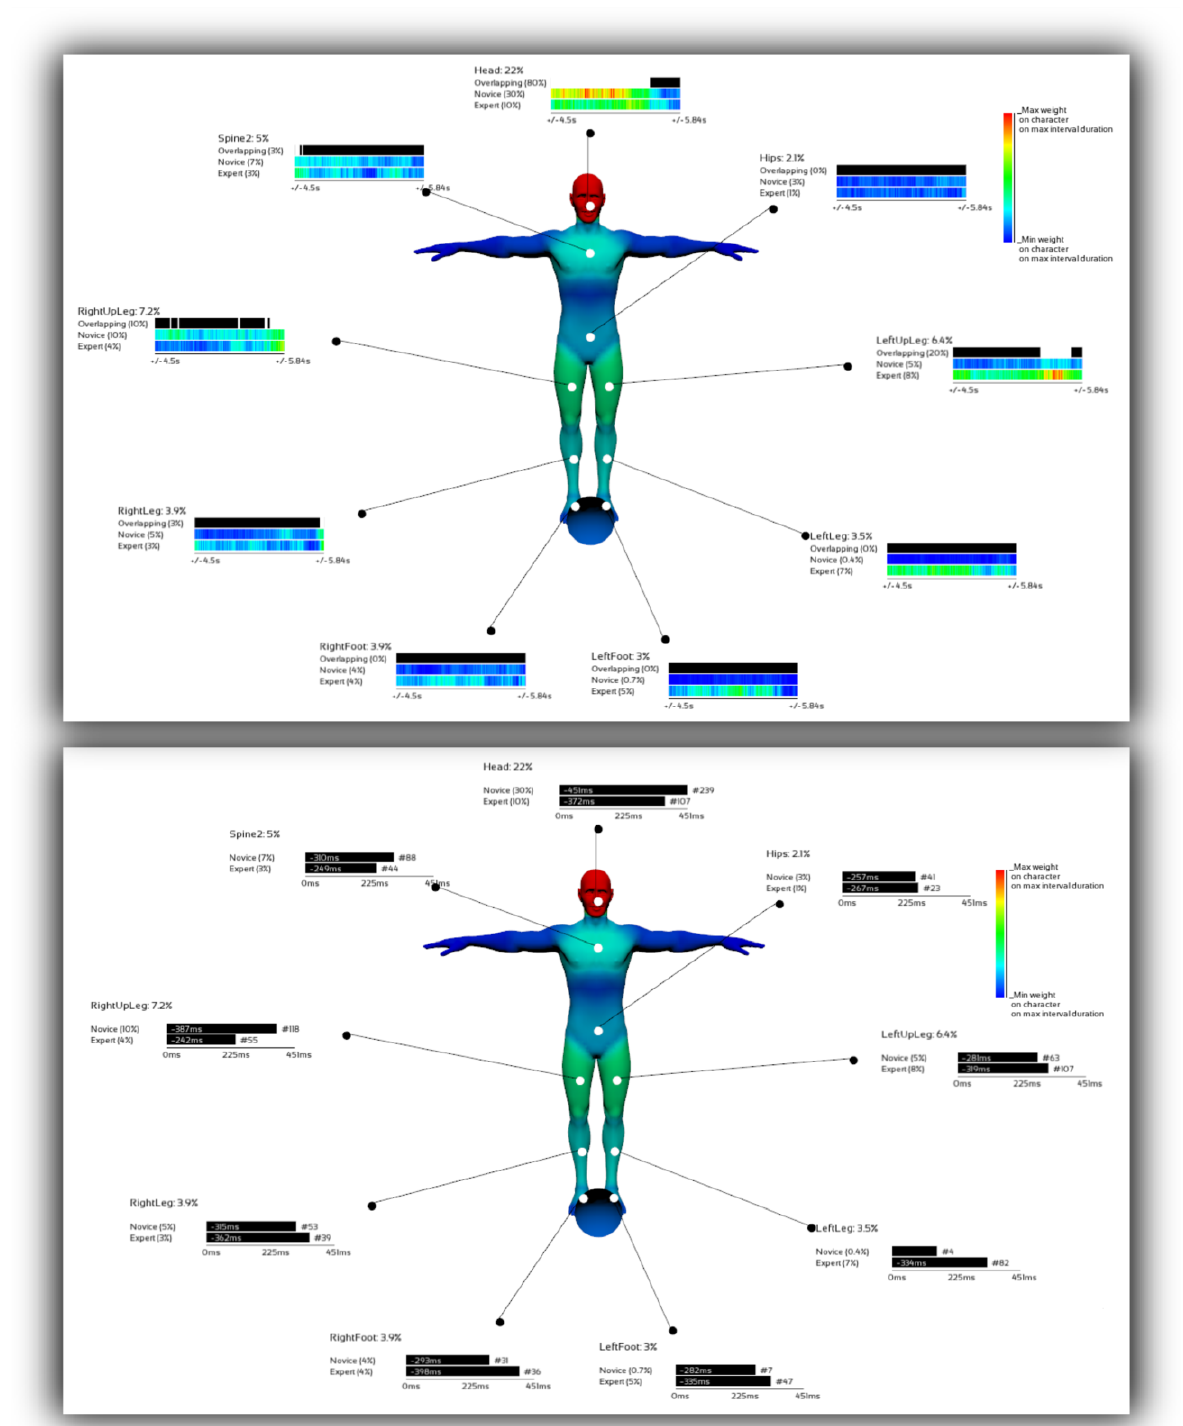
Figure 8. Penalty anticipation. Top: Illustration of gaze distribution average for the two groups of viewers (expert goalkeepers (Expert) and field players (Novice)). Bottom: Illustration of viewers' fixations for each